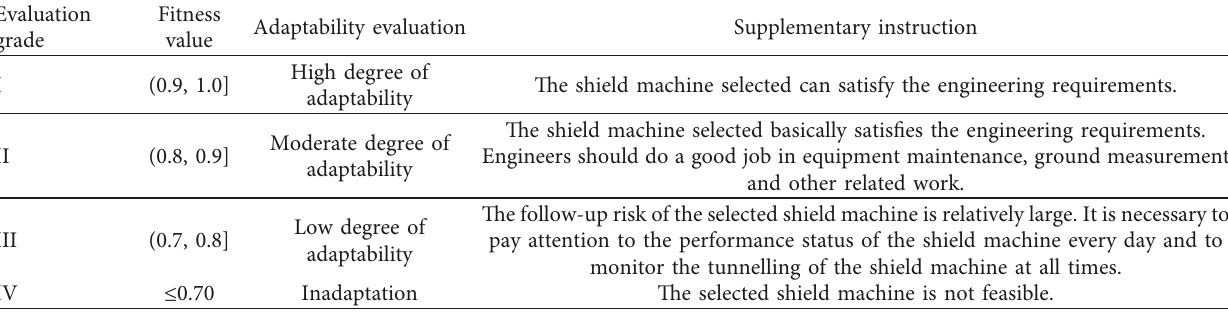
Table 2: Evaluation grade of the adaptability of the shield machine.